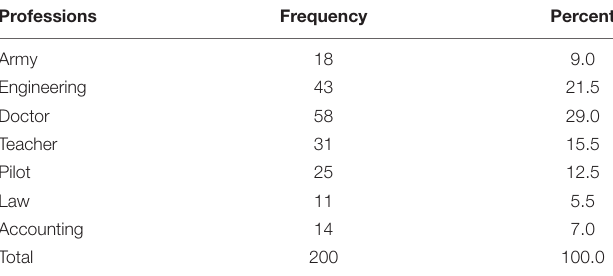
TABLE 1 | Choice of career.